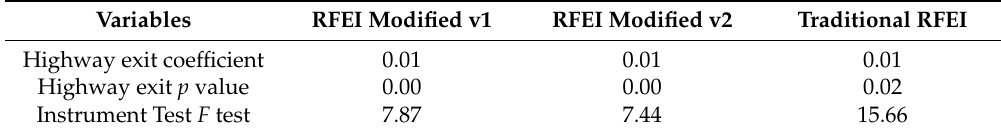
Table 7. Instrumental variables regression analysis, first-stage results ( N =